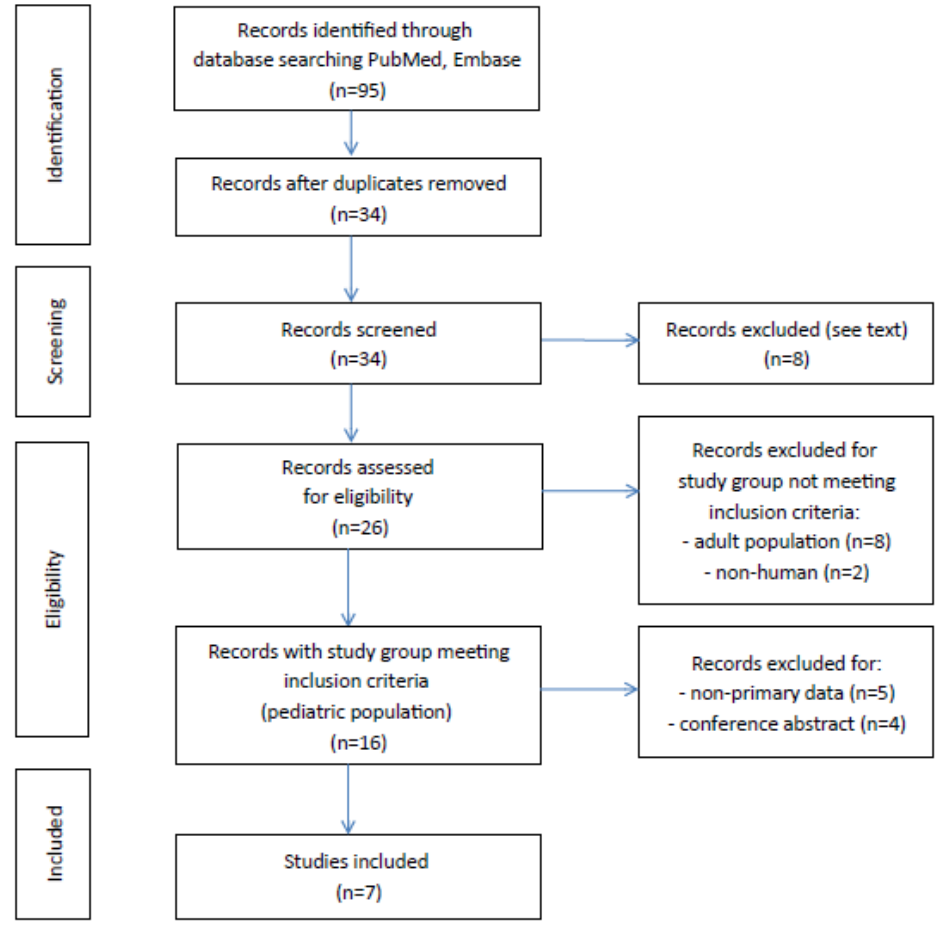
Figure 2. Flowchart illustrating search strategy and study selection.